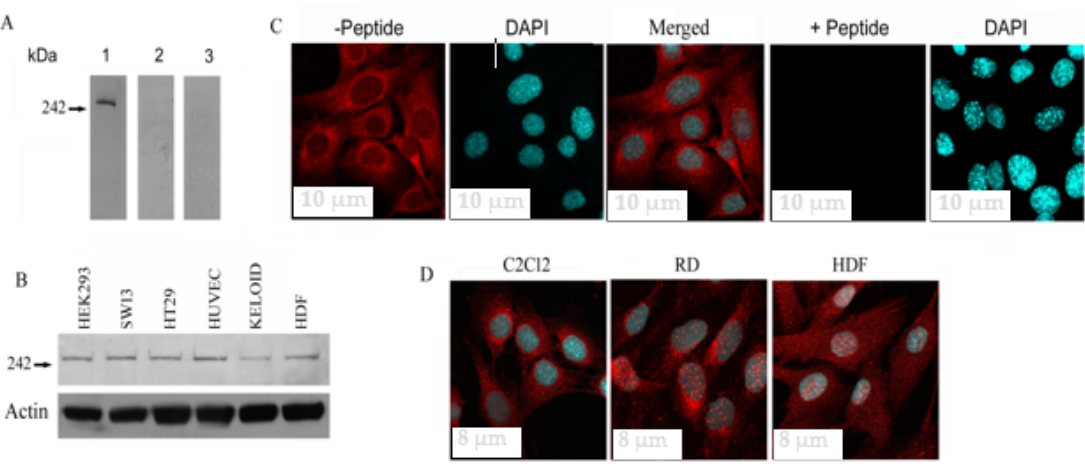
Figure 1. Fer1L5 protein expression in different cells. ( A ) Fe r1L5 antibody characterization. On blots Fer1L5 showed the specific band little above the predicted 242 kDa protein (indicated with arrow). Preimmune serum, blot 2; peptide blocked Fer1L5 anti-serum, blot 3. ( B ) A similar band for Fer1L5 was detected in the mammalian cell lines, HEK293 (human embryonic kidney 293 cells), SW13 (adrenal carcinoma cell line), HT29 (human colon adenocarcinoma cell line), HUVEC (human umbilical vein endothelial cells), KELOID (keloid fibroblasts) and HDF (human dermal fibroblasts) cells. ( C ) C2C12 myoblasts incubated with affinity purified Fer1L5 antibody ( − peptide) and peptide blocked Fer1L5 antibody (+peptide) and the identical confocal settings were used to image the cells. DAPI stains nuclei. Scale bar, 10 µm. ( D ) Z-series sections depicting Fer1L5 expression in C2C12, human rhabdosarcoma (RD) and human dermal fibroblasts (HDF), respectively. Scale bar, 8 µm.